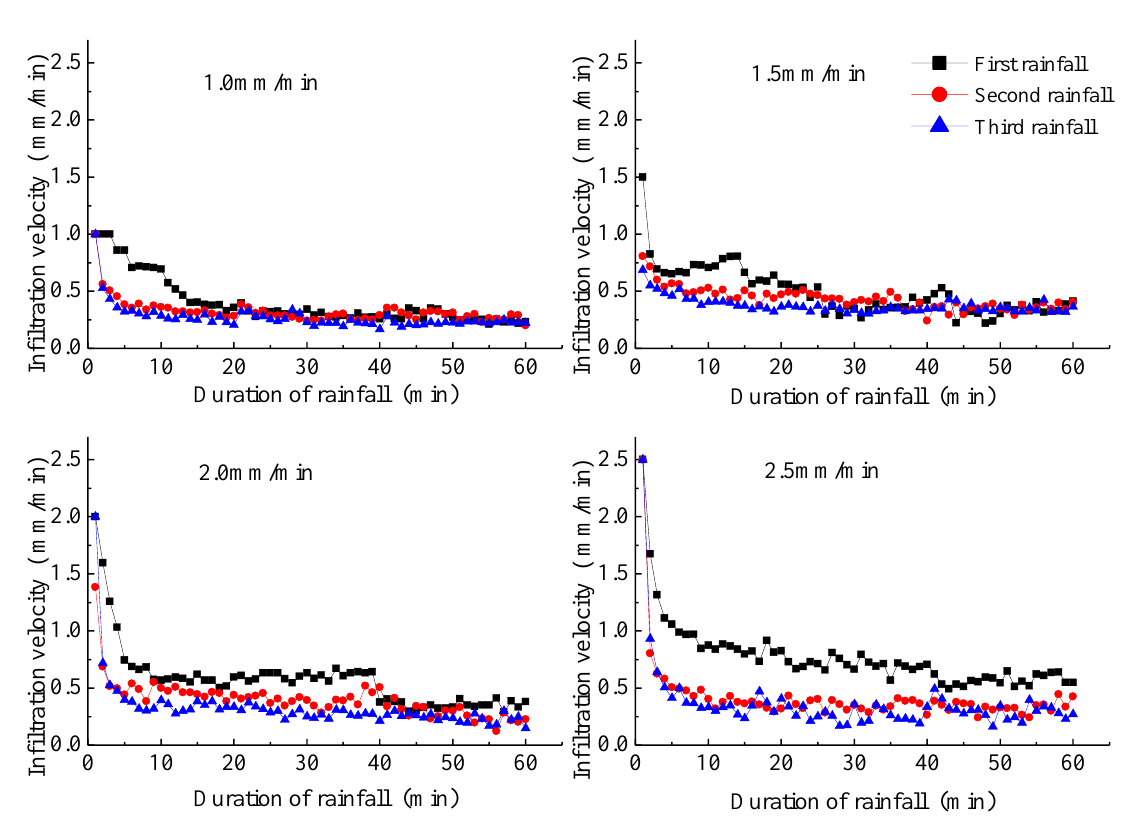
respectively. The stable infiltration velocities of the second rainfall were 0.26, 0.34, 0.25 and 0.33 mm/min, respectively. The stable infiltration velocities of the third rainfall were 0.23, 0.32, 0.23 and 0.28 mm/min, respectively. In the first rainfall, greater rainfall densities were associated with greater stable infiltration velocity of the soil. Similarly, the soil infiltration velocity decreased with increasing rainfall.